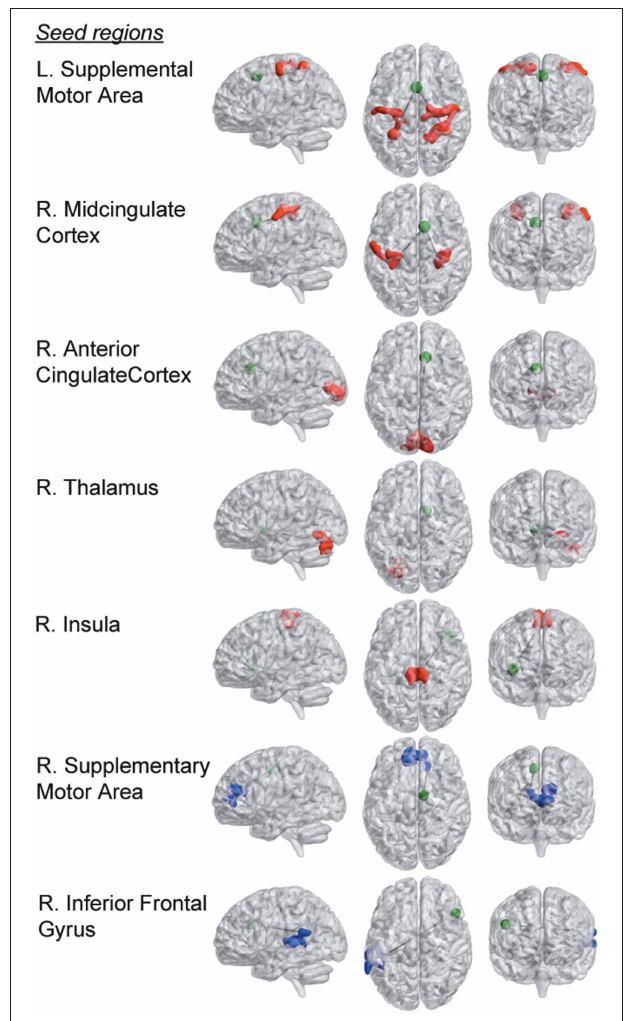
FIGURE 1 | Group differences in functional connectivity of the 159 a-priori defined seed regions within pain processing brain areas. Seed regions are depicted as green spheres (the radius of the seed points has been increased by a factor of 2 for display purposes). Brain areas that display stronger connectivity with respective seed region in the RA compared to the HC group are colored in red, and blue areas represent clusters that are more strongly connected in the HC compared to the RA cohort ( p < 0.0031 , FDR-corrected at the cluster